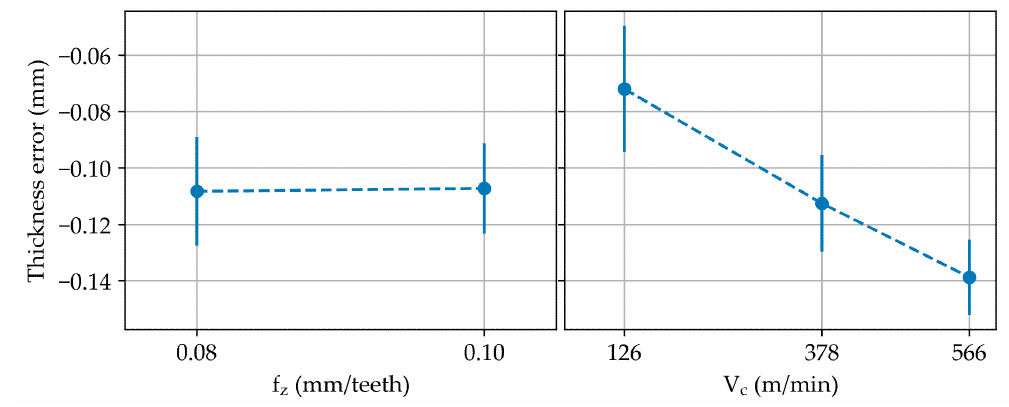
Figure 3. Average final thickness error depending on the feed per teeth ( f z ) and the cutting speed ( V c ).